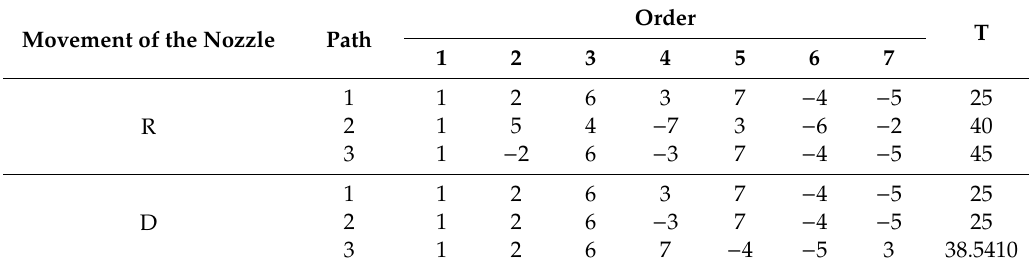
Table 3. Six solutions obtained for Example 1 with seven walls.